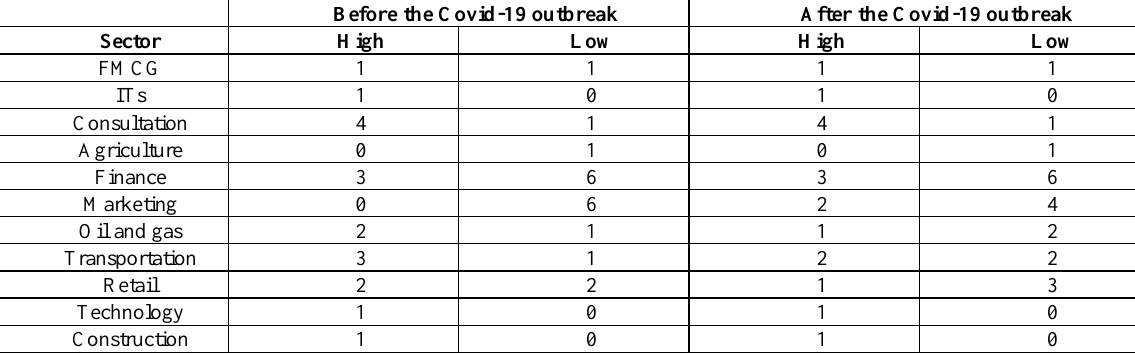
Table 4. Sectoral distribution of the high and low digitalization scores before and after the